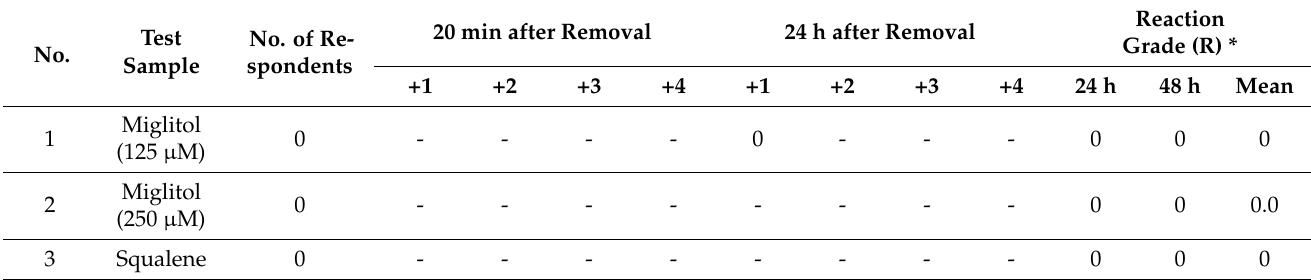
Table 1. The results from the primary human skin irritation tests ( n =